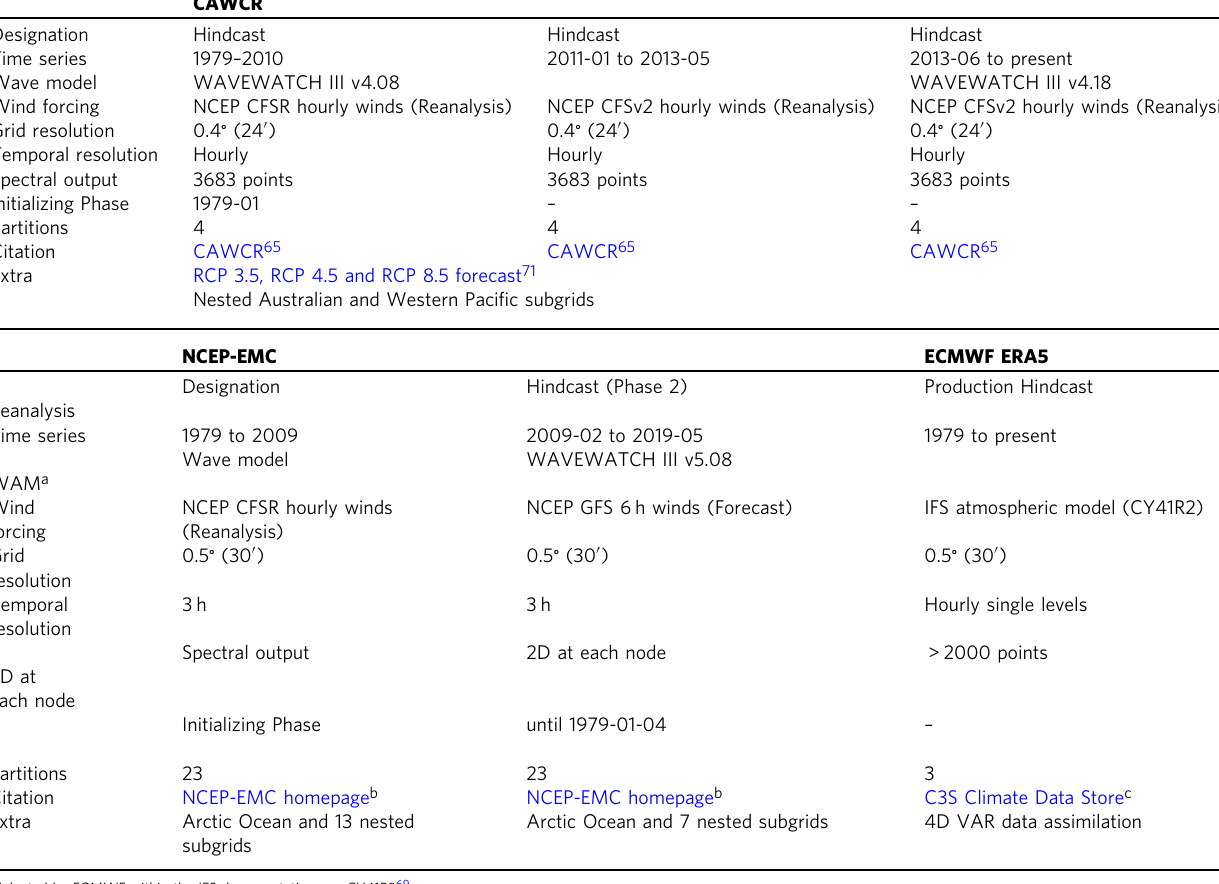
Table 1 Overview on wave data repositories. Data repositories considered for the local wave climate